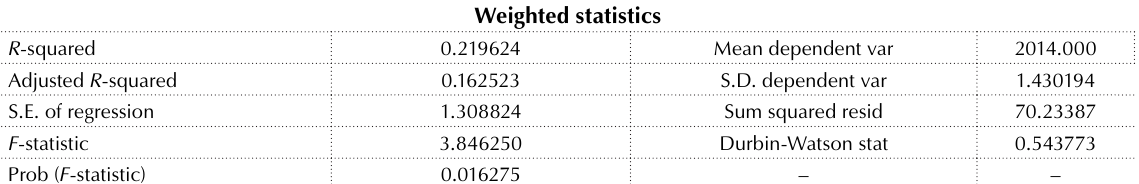
Table 6. Hausman test results Test